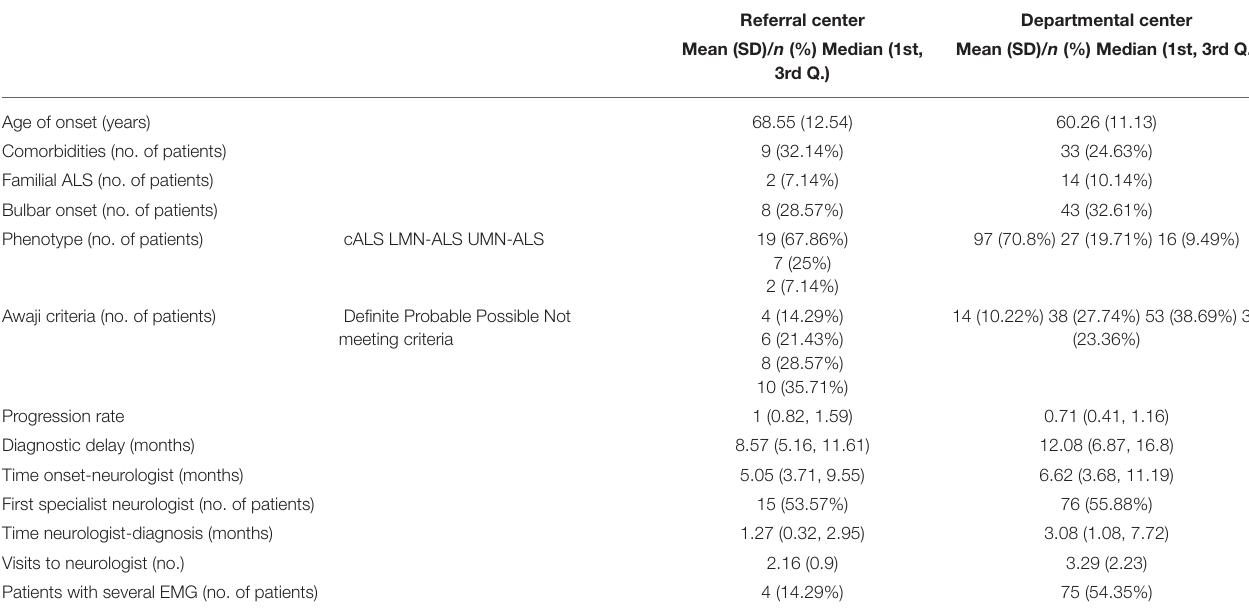
TABLE 1 | Patients La Fe vs. others.